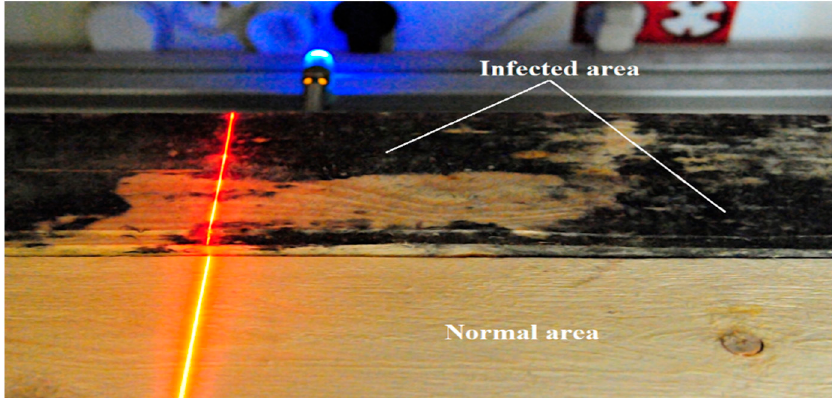
Figure 5. Illumination of the surface of a healthy board and a board infected with blue-veined fungi using a 658 nm laser and a power of P = 20 mW.